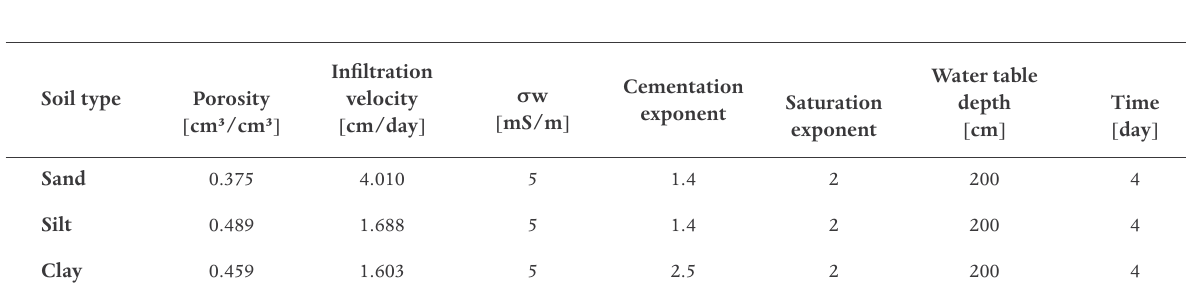
Table 2. Simulation